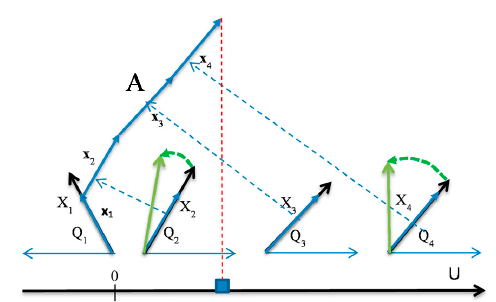
Figure 4. Modifying interactively the coefficients by rotating the ends of selected arrows, X 2 and X 4 are rotated.